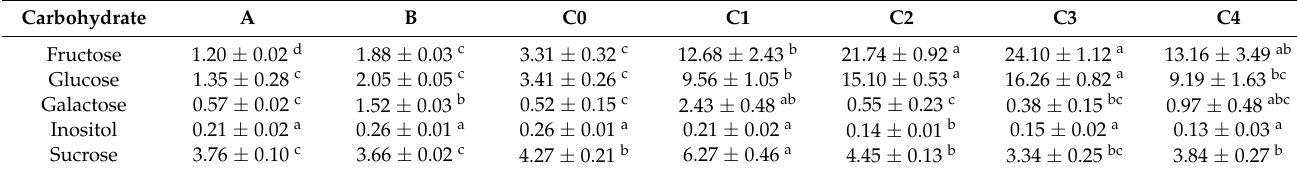
Table 5. Effect of methyl jasmonate (JA-Me) applied in lanolin paste on the middle part of the detached leaves of K. blossfeldiana on carbohydrate content. A—leaves on the plant; B—leaves detached from plant and kept in the inverted position for 4 days; C0—leaves kept in the inverted position and treated with pure lanolin; C1, C2, C3, and C4—leaves kept in the inverted position and treated with 1% JA-Me, 0.5% JA-Me, 0.25% JA-Me, or 0.1% JA-Me in lanolin paste, respectively. Mean results in rows ± standard deviation followed by the same letter were not significantly different ( p < 0.05) according to Tukey’s